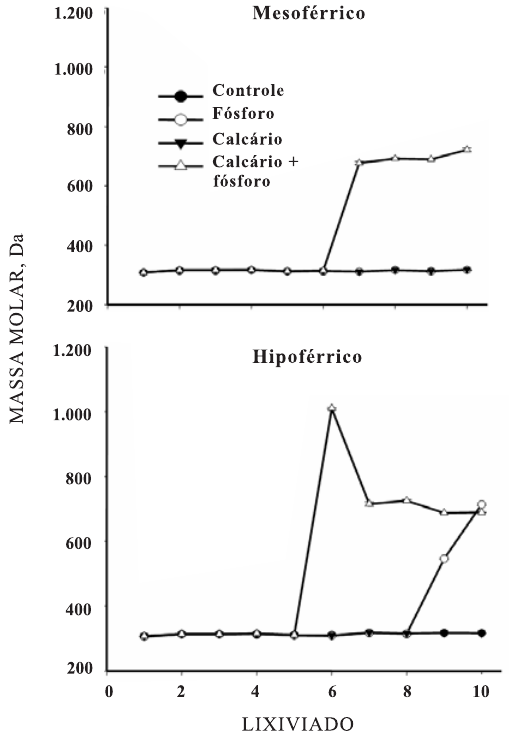
Figura 3. Distribuição de massas molares médias (daltons, Da) de compostos orgânicos em lixiviados de Latossolos Vermelhos (mesoférrico – LV1 e hipoférrico – LV2) tratados com